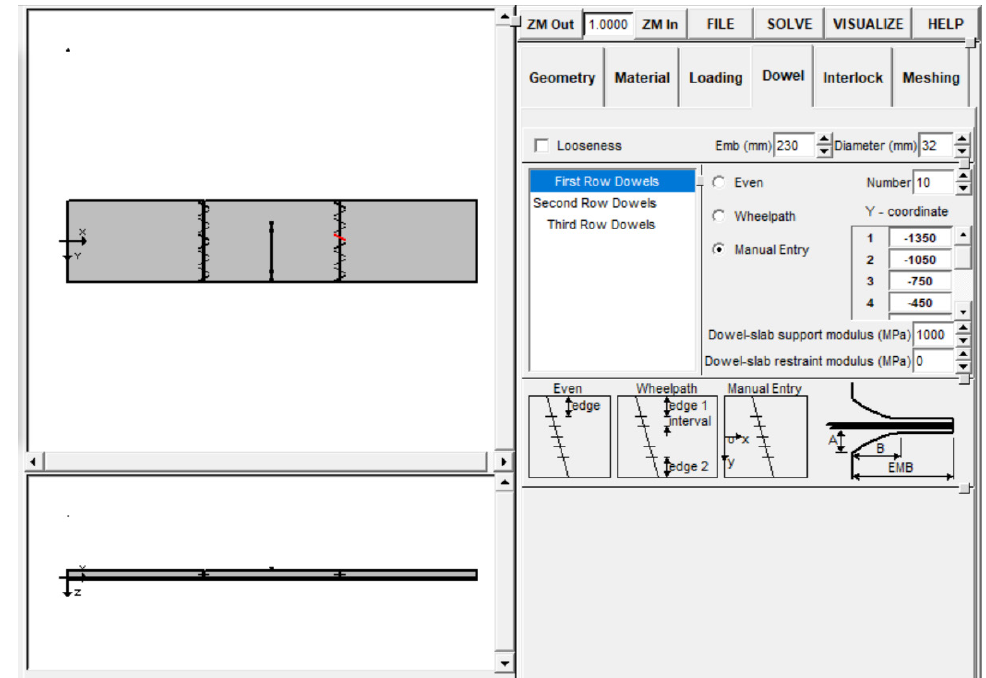
Figure 5. EverFE 2.25 flap for parametrizing dowel bars characteristics in transverse joints.